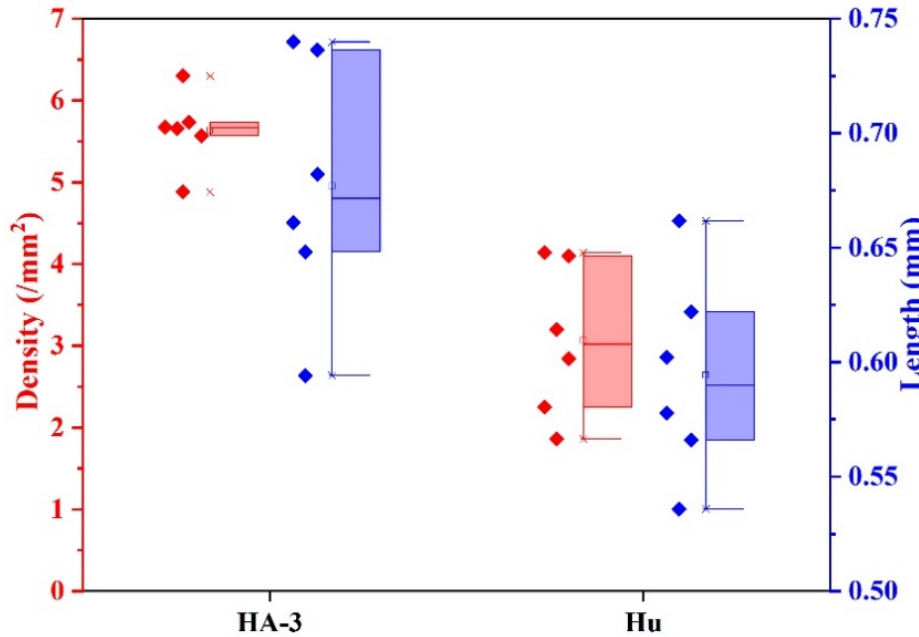
Figure 1. Length and density of leaf hairs of HA-3 and Hu. Table 1. Comparison of stem anatomical structures between HA-3 and Hu.